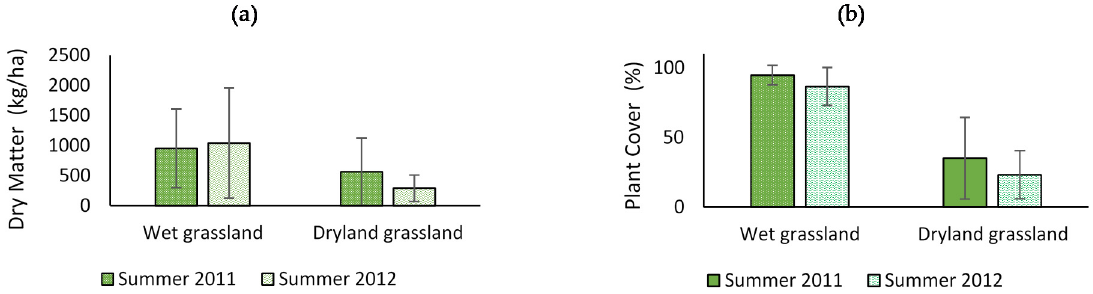
Figure 2. ( a ) Dry matter production and ( b ) plant cover in wet and dryland grasslands in the study area, during the two evaluation seasons. Lines above and below the average indicate one standard deviation.